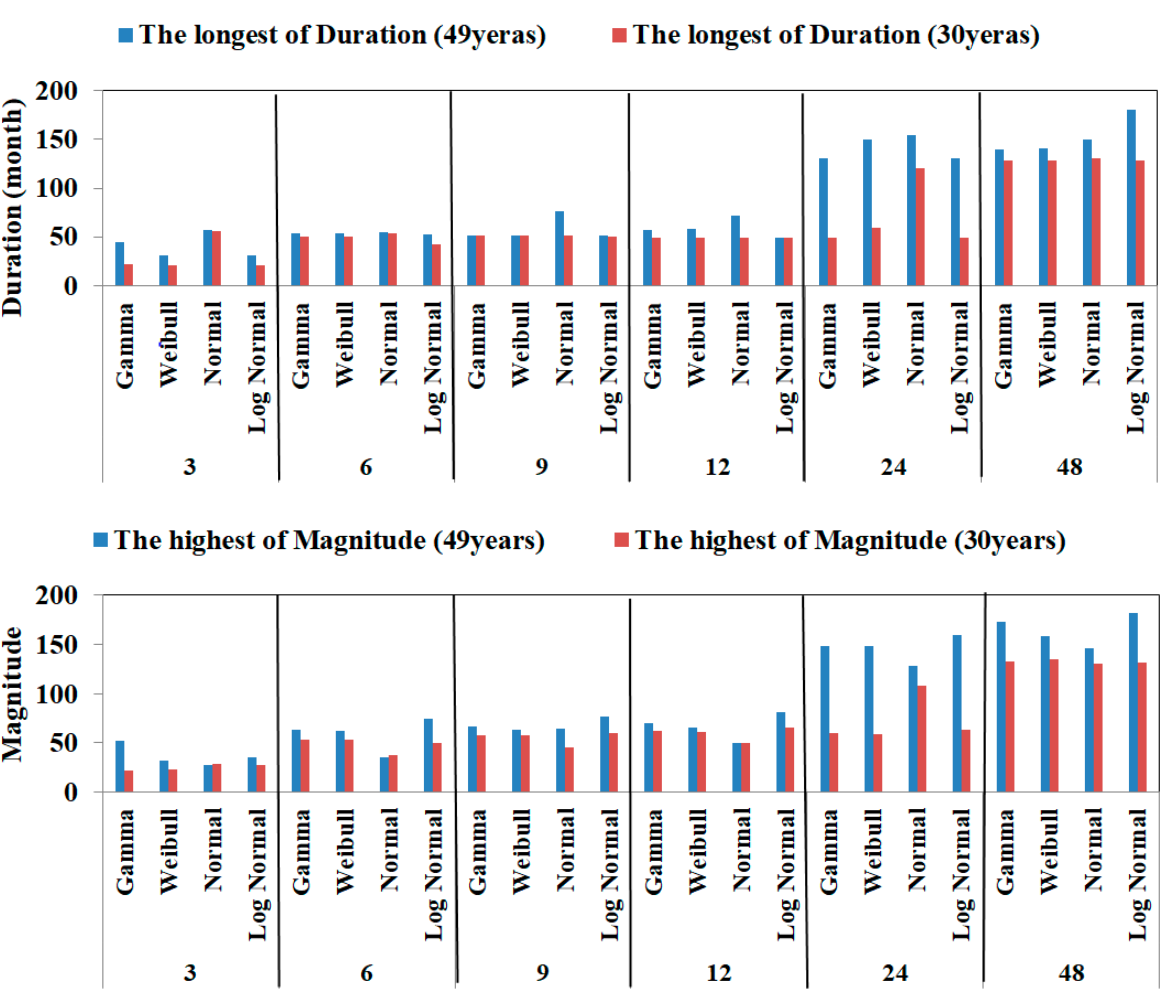
Figure 6. The highest magnitude and the longest duration for 30- and 49-year time periods, different time scales, and distribution functions.